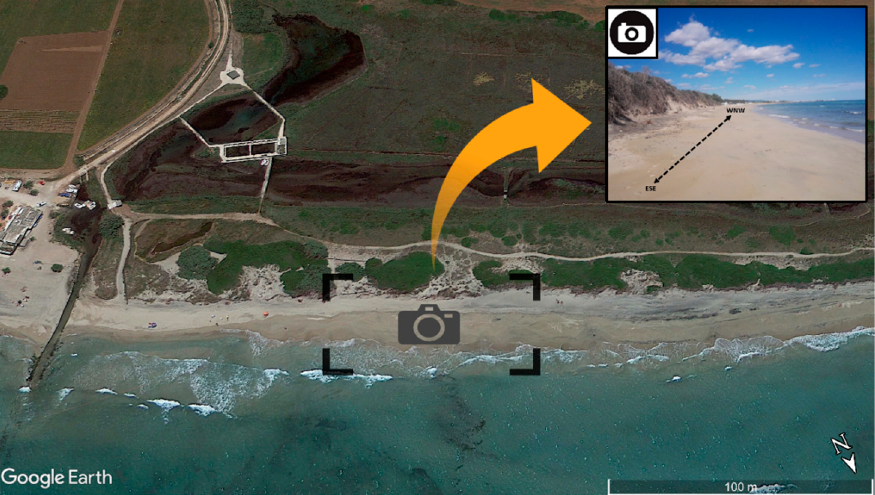
Figure 2. View of the study area (19 July 2018). The characteristics of the beach change quickly and dramatically depending on the storm surge.